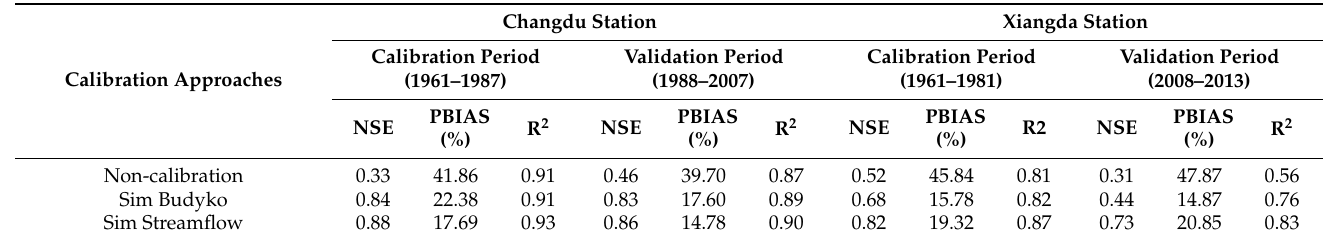
Table 4. Performance of the SWAT model for monthly streamflow simulation using three calibration approaches (Sim Budyko, Sim Streamflow,